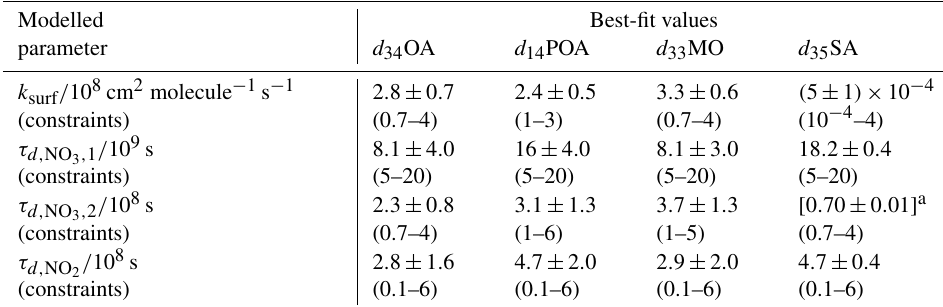
Figure 4. The evolution of the surface concentrations obtained from kinetic modelling using the best-fitted parameters for the data shown in Fig. 3 for (a) the organic reactant (Y), in this case oleic acid; (b) the gas-phase species NO 3 and NO 2 ; and (c) the surface-active ( Z s ), volatile ( Z G ) and soluble ( Z B ) products. Table 2. Results of the kinetic modelling of the experimental data for the d 34 OA–NO 3 , d 14 POA–NO 3 , d 33 MO–NO 3 and d 35 SA–NO 3 systems. The uncertainties correspond to 1 standard